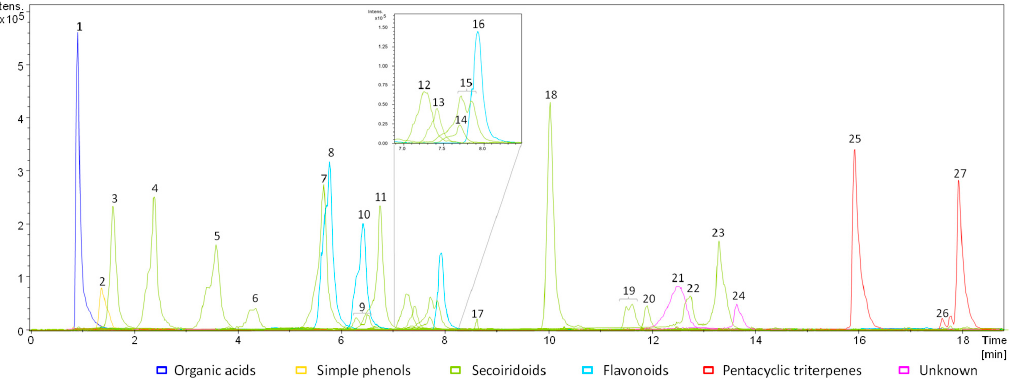
Figure 1. Example of the profile obtained for the extract of one cuspidata sample (316-6-G14) including the chromatograms of the extracted ions of the quantified metabolites. Colors have been used to indicate belonging to the different chemical categories of each numbered peak: organic acids (dark blue), simple phenols (yellow), secoiridoids (green), flavonoids (light blue), pentacyclic triterpenes (red) and unknown compounds (pink).